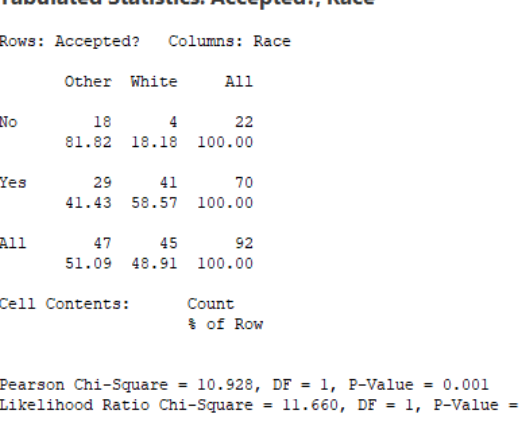
Figure 5. Contingency table of acceptation by race.